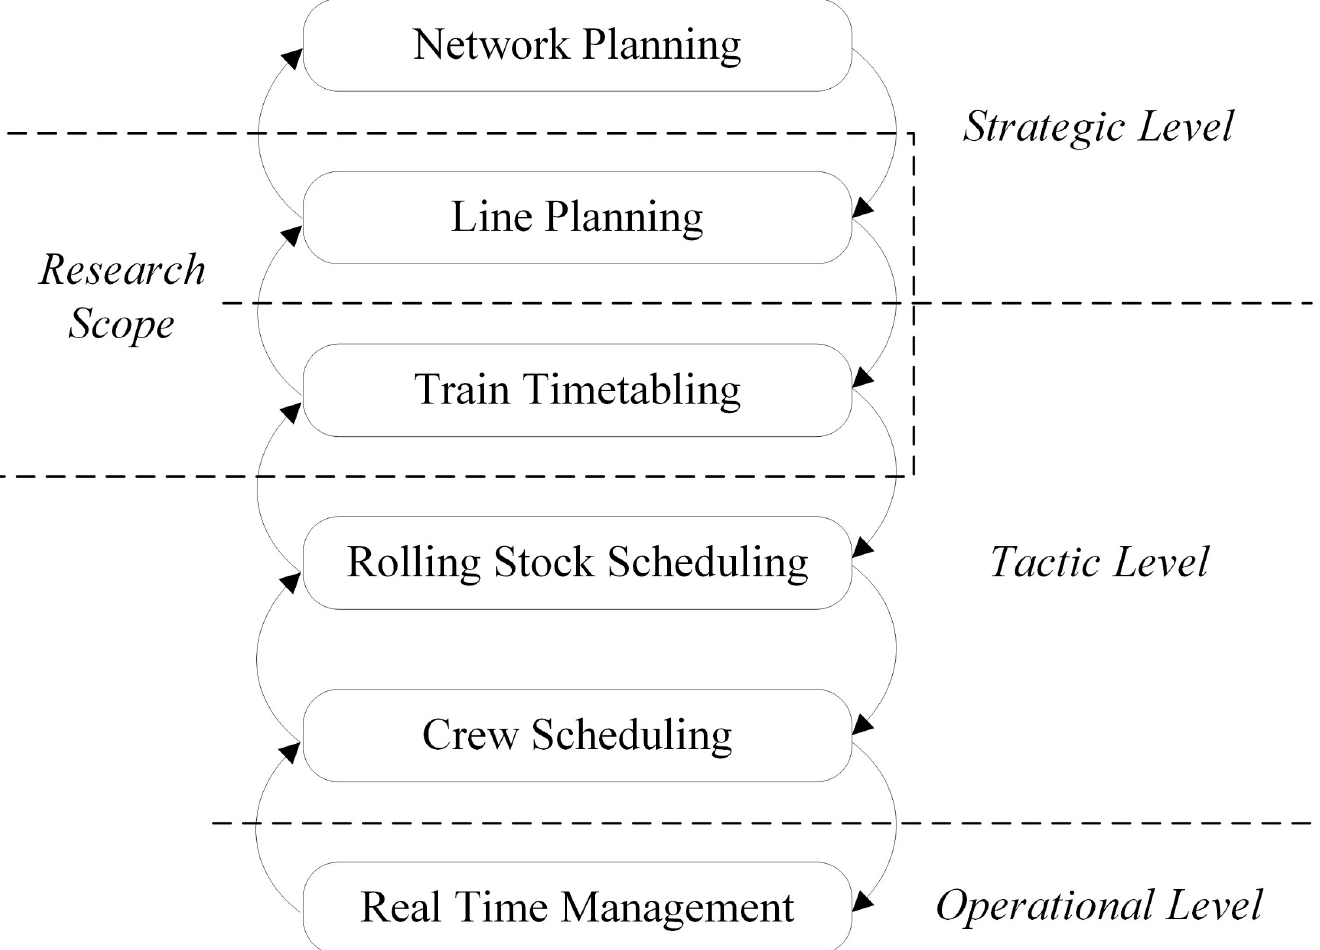
Fig 1. Railway transport planning